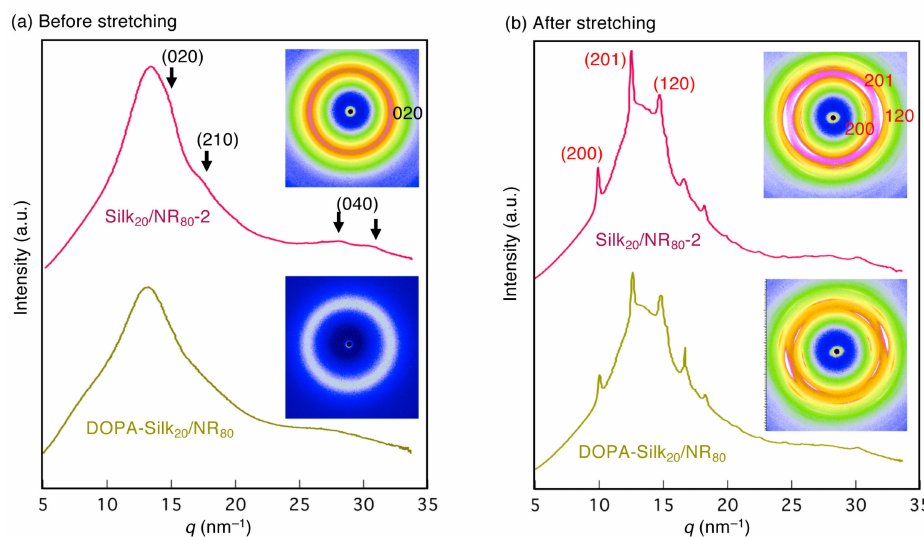
Figure 14. 1D WAXD profiles of silk 20 / NR 80 -2 and DOPA-silk 20 / NR 80 before and after the stretching treatment. ( a )Beforethestretching, the broadamorphous halopeakwasobserved forDOPA-silk 20 / NR 80 , whereastheamorphoushaloandtheBraggreflections(020) / (210) / (040)insilkwormsilkfrom B.mori were observed for silk 20 / NR 80 -2 [55–57]. ( b ) After approximately 350% and 760% stretching deformation for silk 20 / NR 80 -2 and DOPA-silk 20 / NR 80 , respectively, the peaks originated from the di ff ractions, (200) / (201) / (120), of the strain-induced crystallization of NR were detected. The assignment is based